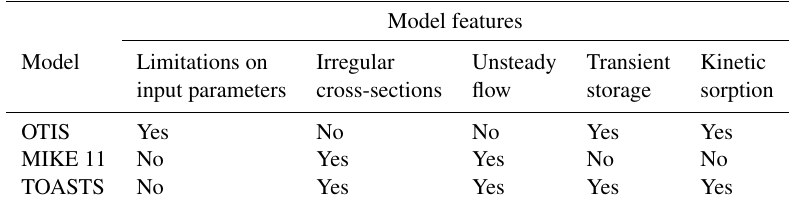
Table 1. Comparison of the features of the three models used in this study.